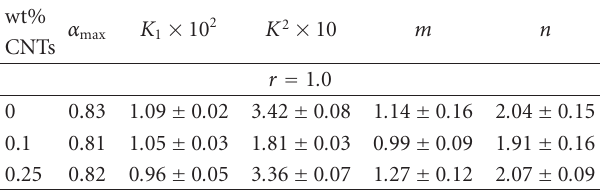
Table 3: Kinetic parameters from isothermal DSC thermograms. wt% α max K 1 × 10 2